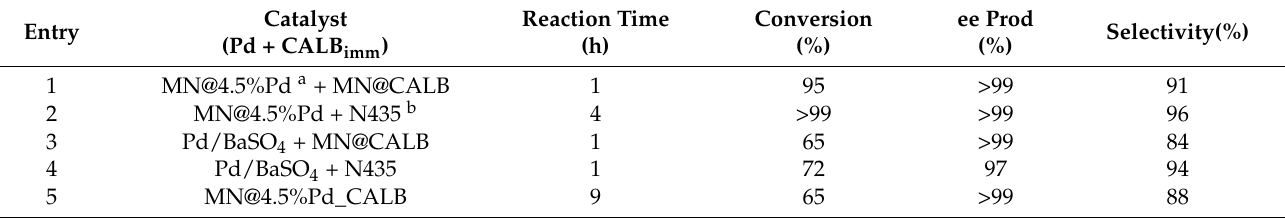
Table 5. DKR of biocatalysts using ammonium formate in continuous-flow condition